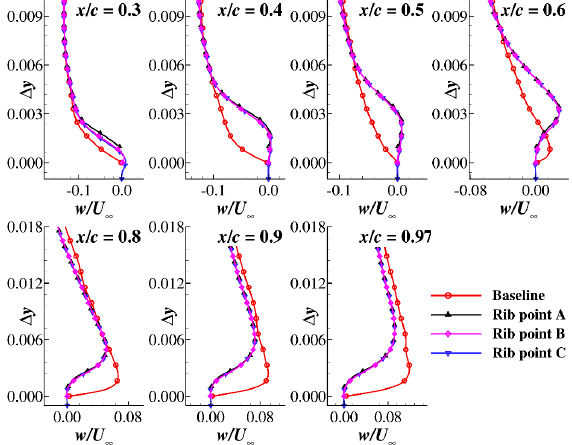
Figure 15. w velocity profiles of the seven streamwise locations.